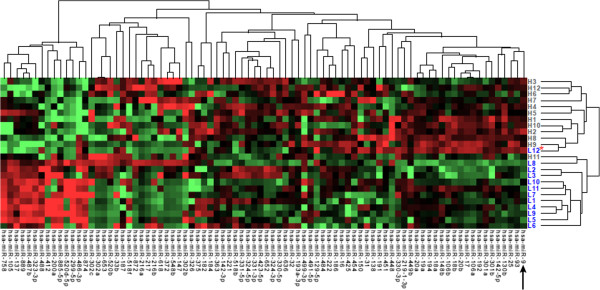
MiRNA expression in primary canine MCTs is associated with biological behavior. Primary canine MCTs were obtained from dogs diagnosed with benign tumors (n = 12) or biologically high grade metastatic tumors (n = 12). Real-time PCR profiling was performed using Applied Biosystems Human TaqMan Low Density miRNA Arrays to assess mature miRNA expression in primary tumors. Unsupervised hierarchical cluster analysis separated samples into two groups based on biological behavior and demonstrate unique miRNA expression profiles associated with biologically low-grade (L) tumors or high-grade (H) tumors (P < 0.05). (*) indicates primary tumor sample from a dog with a benign mast cell tumor that clustered with the biologically high grade MCT group.